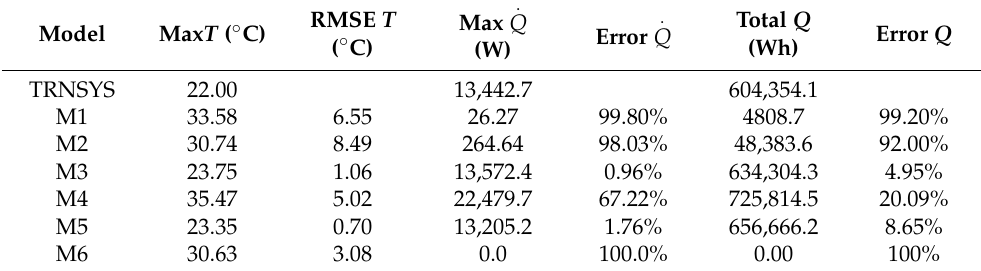
Table 2. Model output in a closed loop to track indoor temperature for TRNSYS.